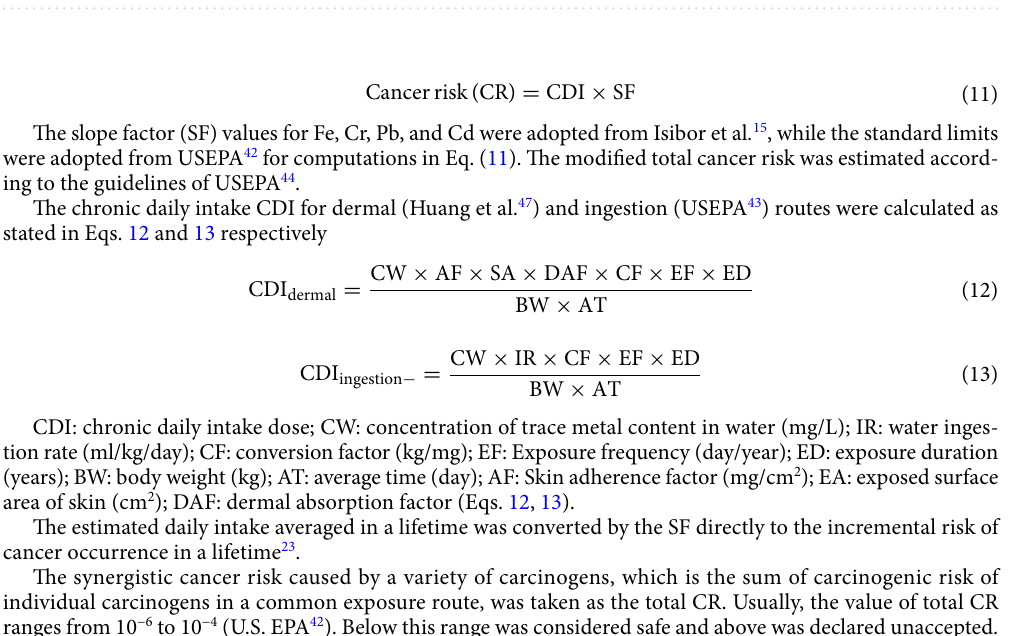
Table 2. Reference oral and dermal doses adopted for the study. RfD reference oral dose